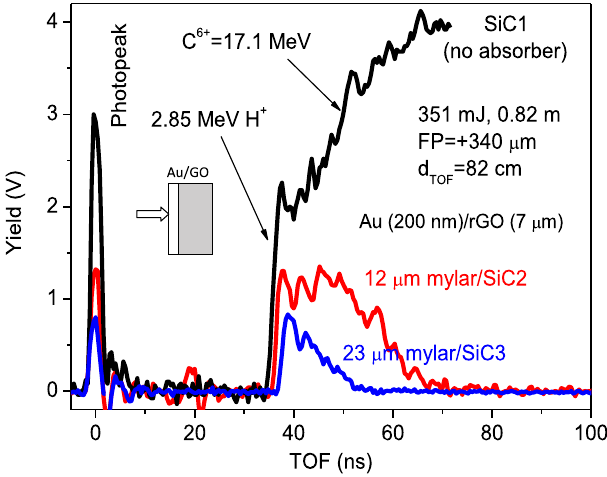
FIG. 4. Comparison of SiC-TOF spectra relative to the maxi- mum ion acceleration with SiC without and with different thickness of Mylar absorber.